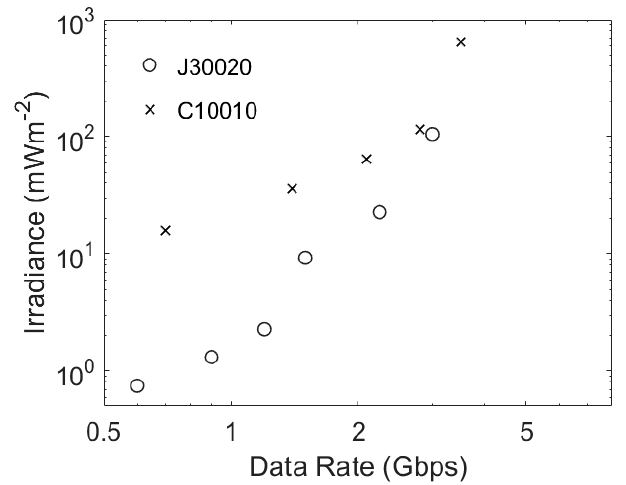
Figure 8. The estimated performance of a J30020, a C1000, and a C10020. These results were obtained by first using the ratio of the bit time to the estimated equivalent Gaussian pulse width to determine the ISI count rate penalty using the results in Figure 7a. This was then converted into the required irradiance using the relevant SiPM parameters and Equation (6).